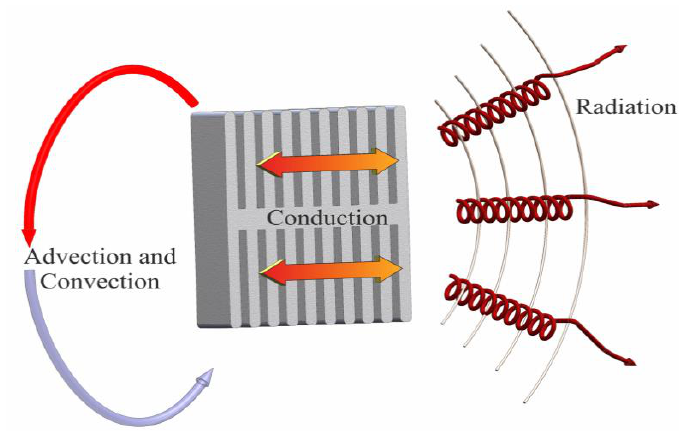
Figure 7. Representation of the three types of heat transfer.